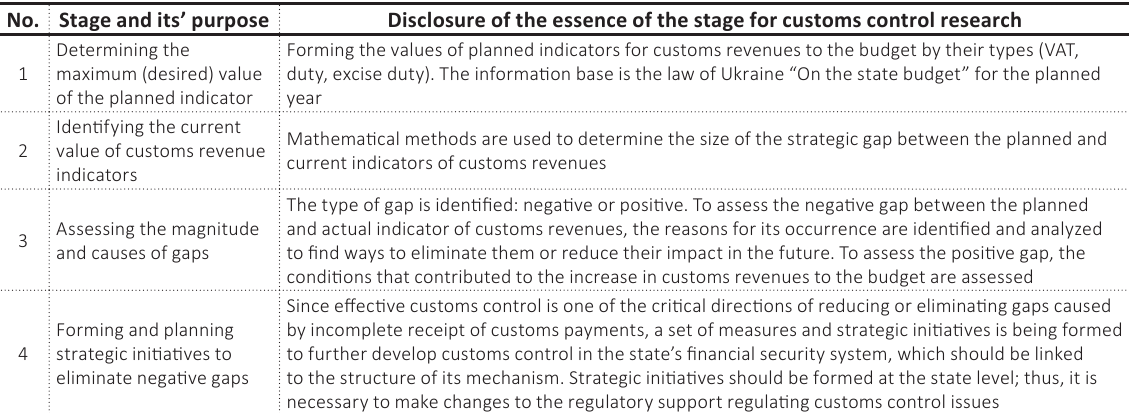
Table 1. Main stages of gap analysis in assessing customs revenue for customs control research No. Stage and its’